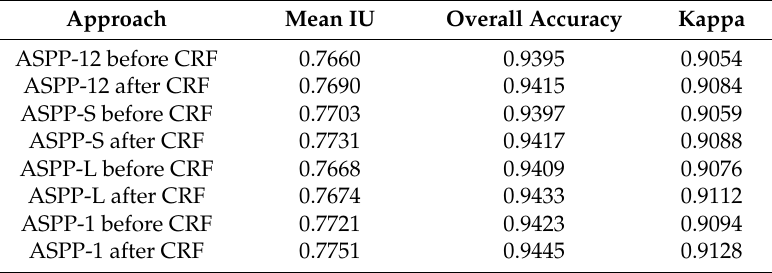
Table 7. Experimental results of CRF.